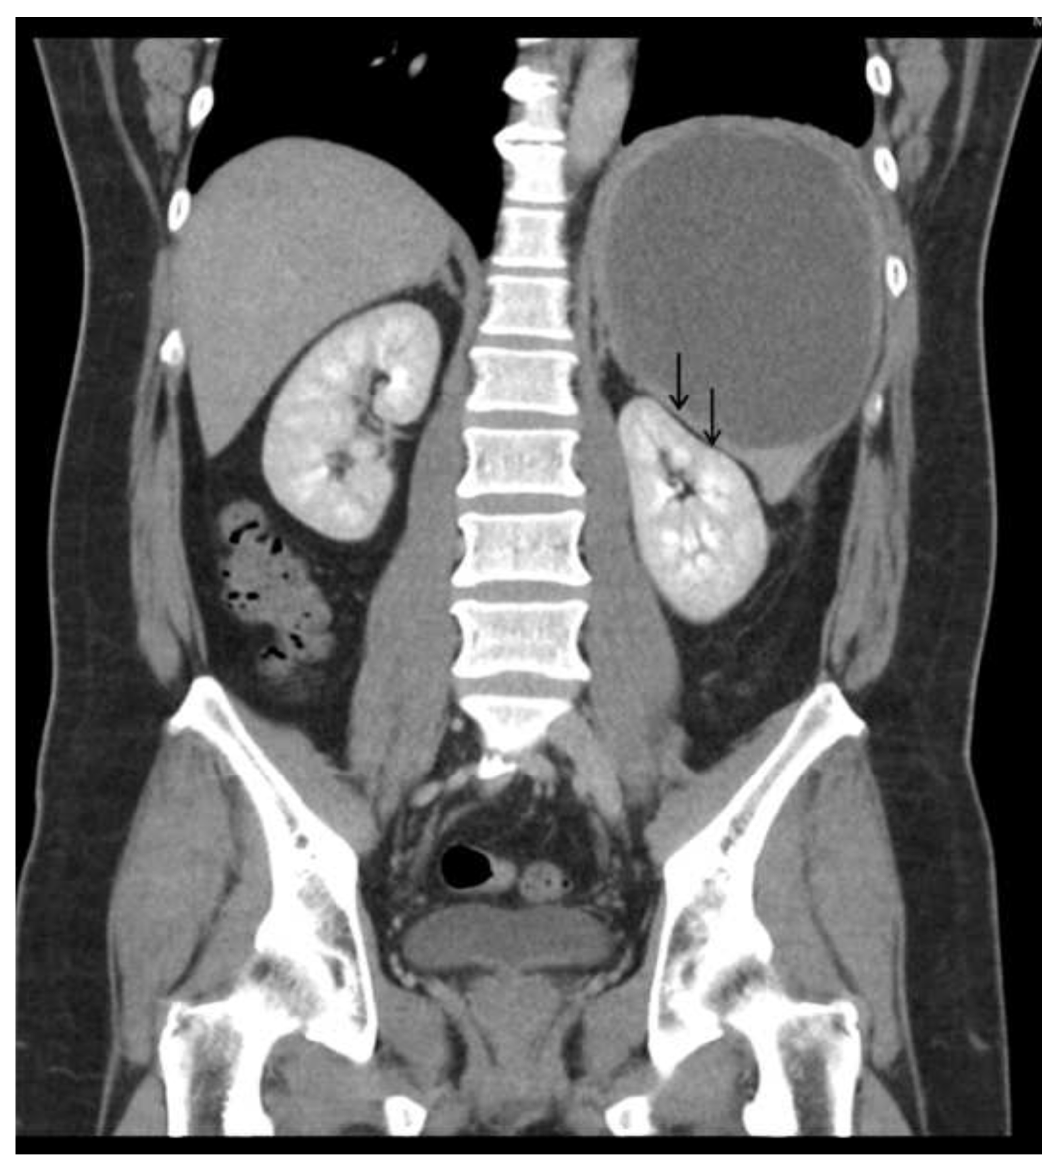
Figure 3. Abdominal CT scan showed the mass was pushing the left kidney inward and down. Lymphoma is the most common malignancy of the spleen, but primary lymphoma of the spleen is very rare with an incidence rate of <1% under the strict criteria for diagnosis expounded by Das Gupta et al. According to their criteria, diagnosis of primary splenic lymphoma should only be made when the disease is confined to the spleen but may also involve the hilar lymph nodes with no recurrence of the disease after splenectomy [1–3]. In our case, the patient presented with a large splenic cystic tumor that did not affect other organs, and there was no occurrence after splenectomy and